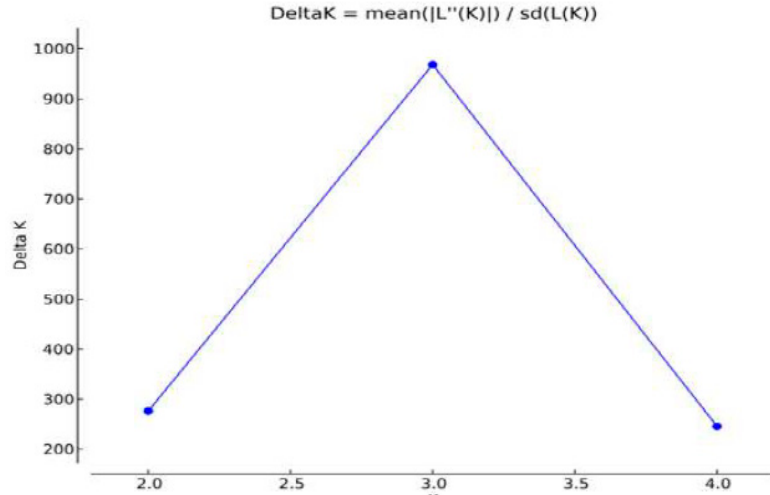
Figure 4. Magnitude of Δ K as a function of K given by the average of 5 independent runs with 500,000 interactions each and x burn-in period. The value that stands out represents the real value of K, that is, the number of inferred populations.